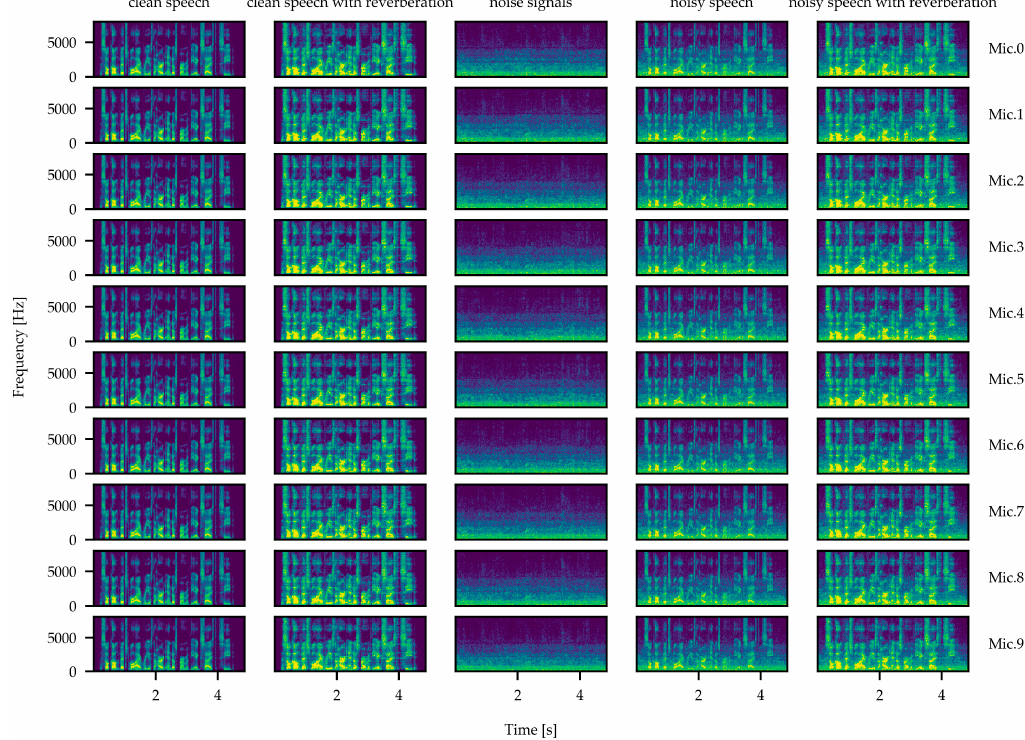
Figure 7. The spectrograms of clean speech, noisy speech, clean speech with reverberation, noisy speech with reverberation, and noise signals of microphone (Mic.) array for Target 1 when the RT 60 is 500 ms and the signal-to-noise ratio (SNR) level is 5 dB.